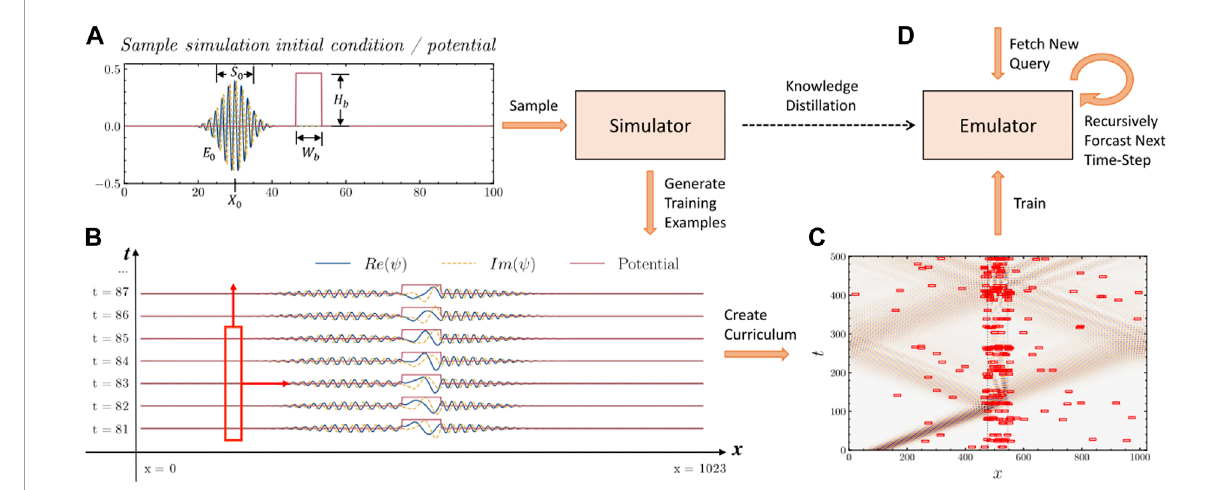
FIGURE 2 Framework for Training a Machine Learning-Based Quantum Dynamics Emulator. (A) , We sample initial conditions, according to which we generate a set of physical simulations. (B) , By selecting small space and time slices (illustrated by the sliding red window), we construct individual training examples. (C) , We sample from the space of all possible training examples to create a training curriculum. (D) , Finally, the machine learning-based emulator learns from the prepared curriculum of training examples. We test the emulator by selecting novel cases and by recursively forecasting the next time steps of the system